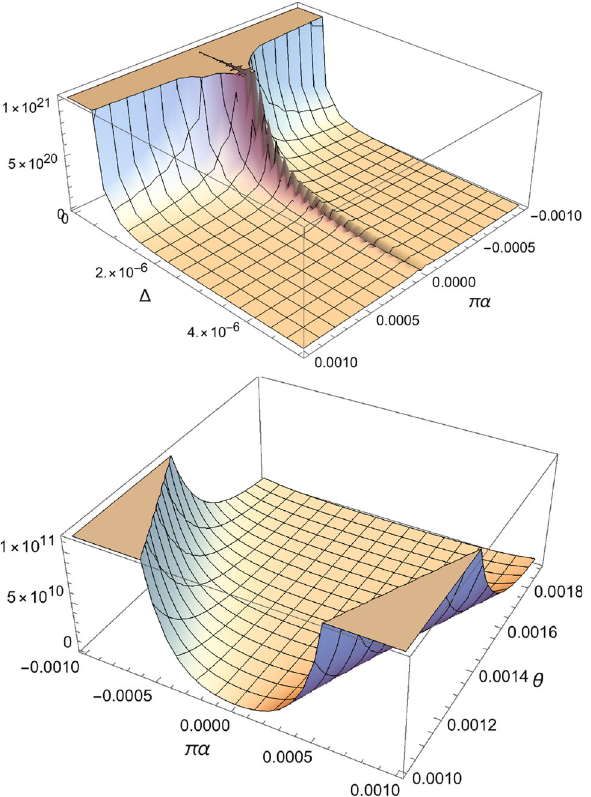
Fig. 2 Three dimensional plots of the differential cross section (5.2), as a function of either (cid:11) = θ −| πα | > 0 and πα (upper panel), or θ and πα (lower panel), for the case θ ≥ | πα | (cid:13)= 0. The lensing of particles when θ → | πα | (cid:13)= 0 is evident. We deliberately kept both signs of πα (although in the concrete cases studied in this section α ≤ 0), to demonstrate a branch cut at πα = 0, which defines the no deficit limit, for which the cross section